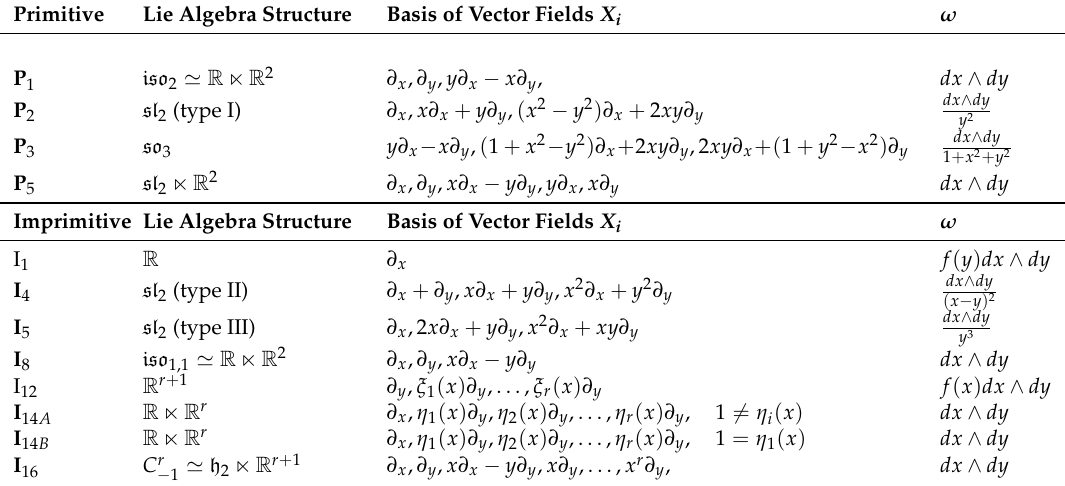
Table 1. Classes of VG Lie algebras of Hamiltonian vector fields on R 2 (see References [9,10,20]). In particular, every Lie algebra consists of Hamiltonian vector fields on the submanifold of R 2 where the given symplectic form is well defined. The functions ξ 1 ( x ) , . . . , ξ r ( x ) and 1 are any set of linearly independent functions, while η 1 ( x ) , . . . , η r ( x ) form a basis of fundamental solutions for an r -order homogeneous differential equation with constant coefficients ([20] pp. 470–471). Finally, g 1 (cid:110) g 2 stands for the semi-direct product of the Lie algebras g 1 and g 2 , where g 2 becomes an ideal of g 1 (cid:110) g 2 . We assume that i = 1, . . . , r and r ≥ 1. Locally transitive VG Lie algebras are written in